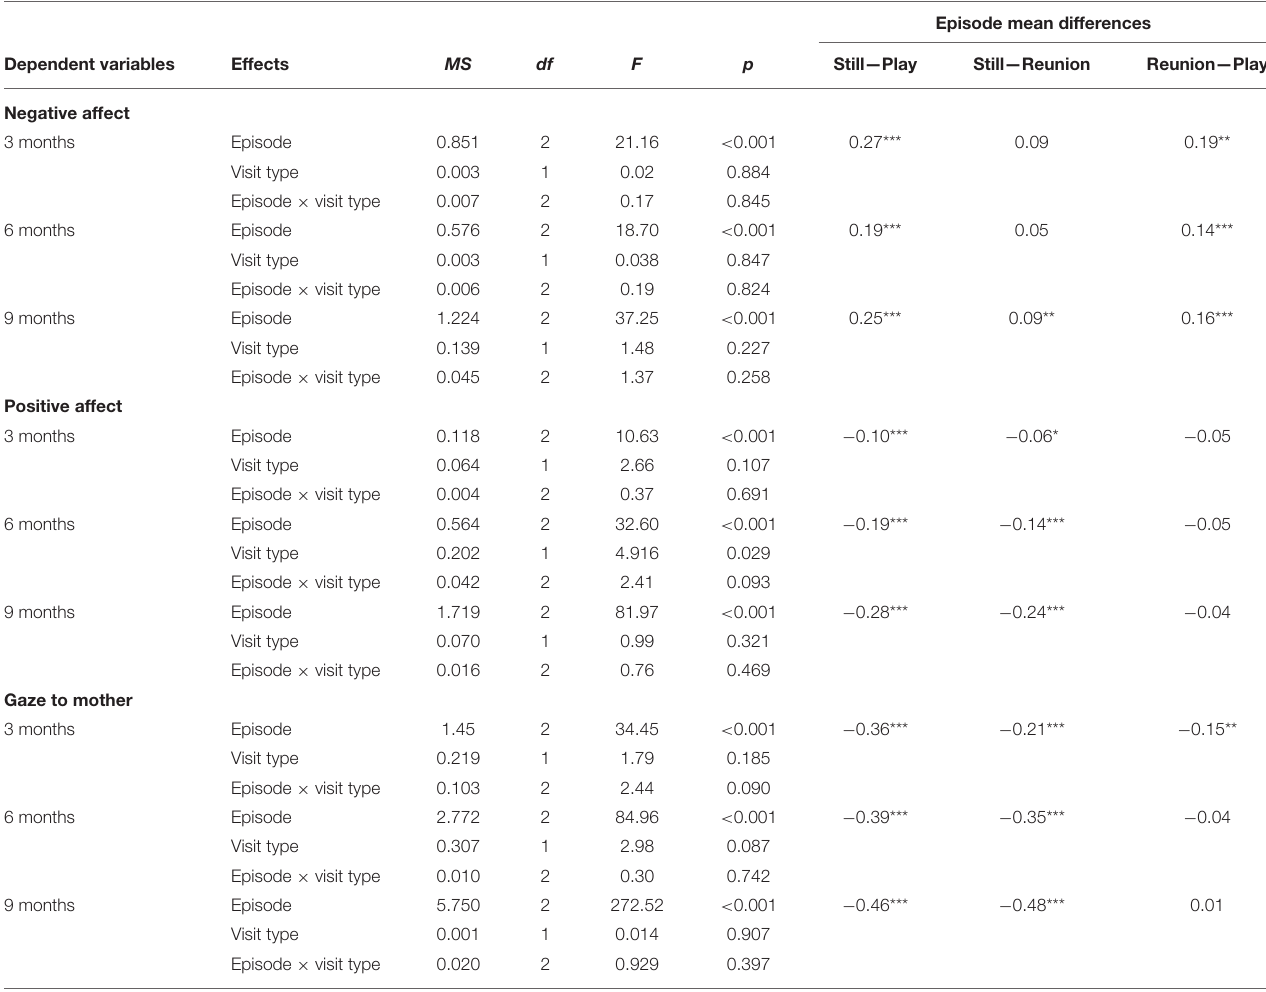
TABLE 5 | Tests of infant behavioral change at each time point as a function of SFP episode and visit type.